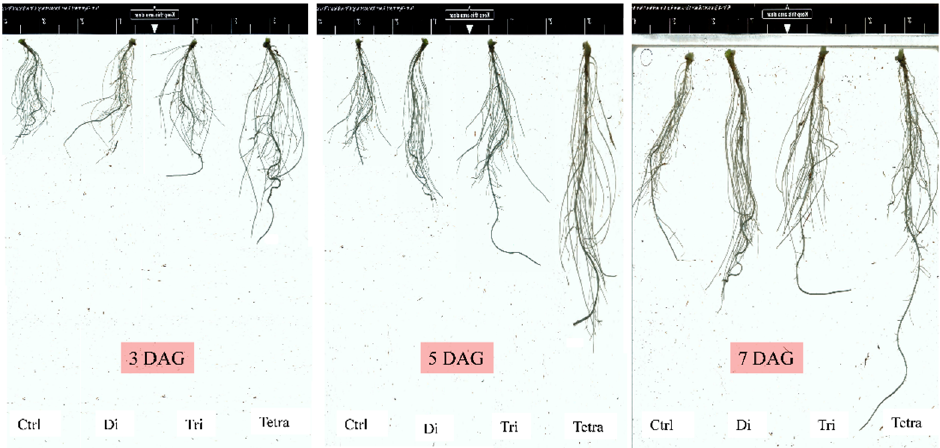
Figure 8. Roots’ growth and development of Xijiaqiangsheng rootstock grafted with splice methods among Cntl, Di, Tri, and Tetra watermelon at 3, 5, and 7 DAG. Cntl: control without grafting, Di: Diploid, Tri: triploid, Tetra: Tetraploid, DAG: Days after grafting.